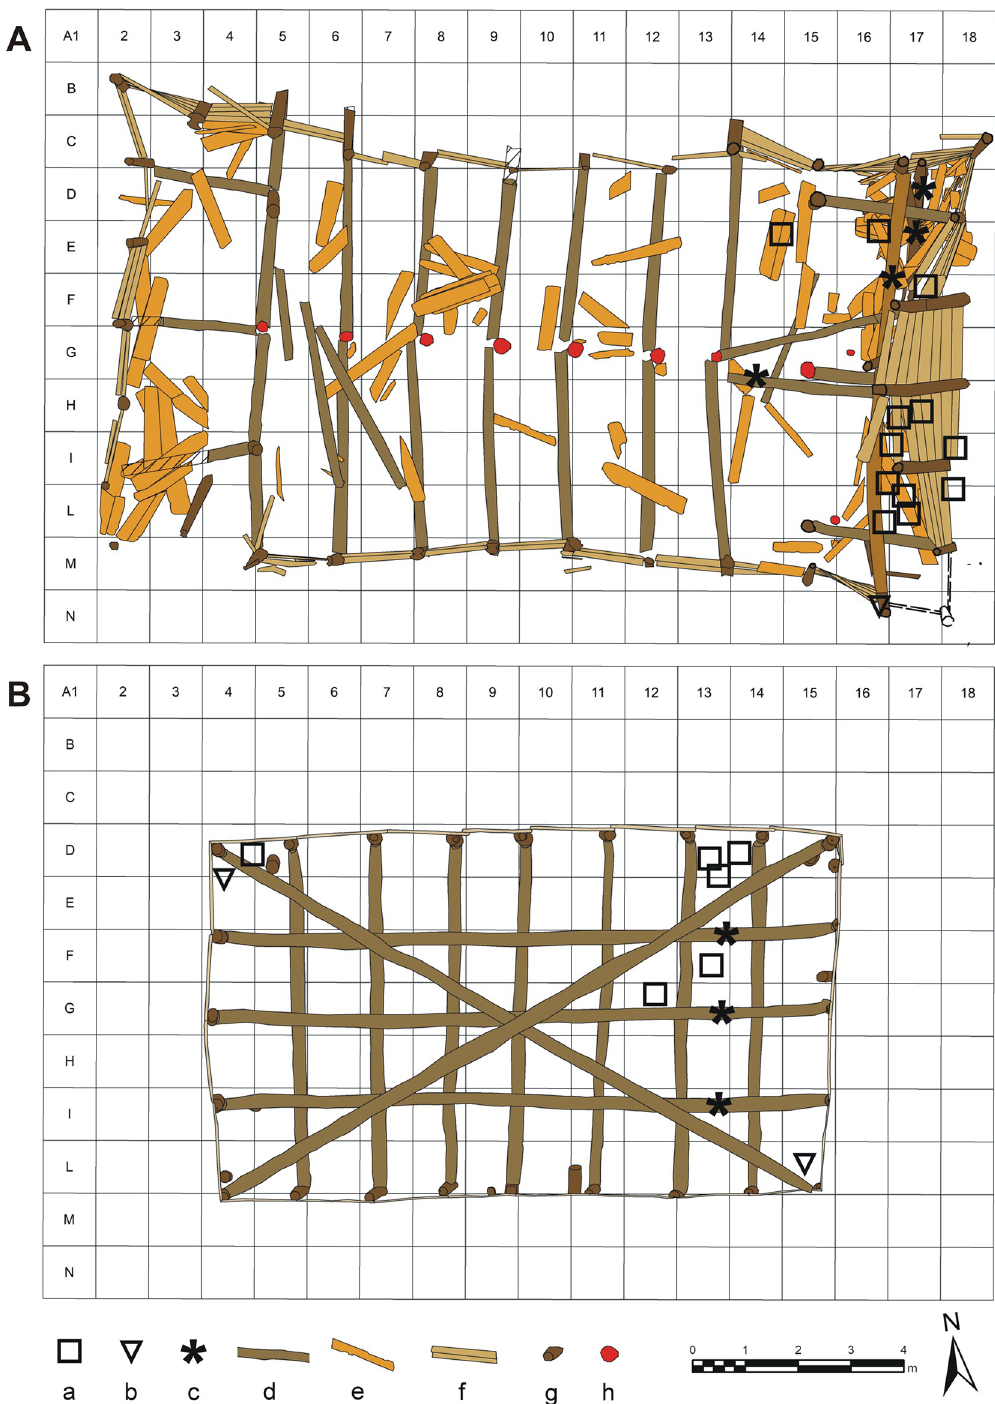
Fig 10. Location of the samples submitted to the dendrochronological analysis. (A) lower structure, (B) upper structure: a) sample of board, b) sample of post, c) sample of beam, d) beam, e) scattered board inside the lower structure, f) standing board, g) post, h) post